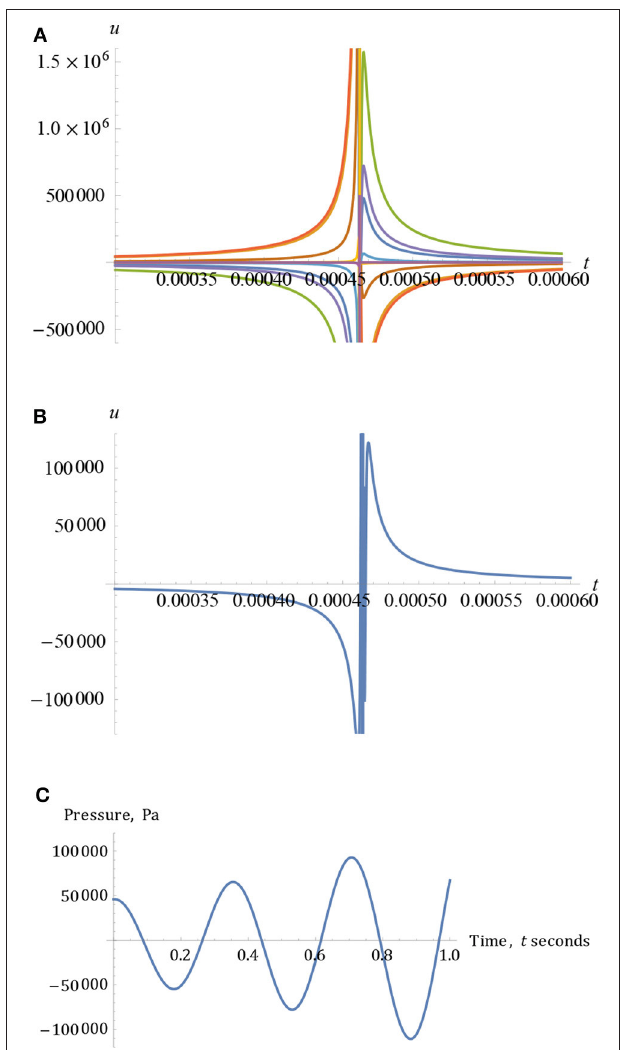
FIGURE 9 | (A) The variation of wave-pressure vs. time for a series of different transmitted and reflected waves described by Equation (76). (B) The variation of wave-pressure vs. time for the superposition of each of the waves in (A) there is a chaotic region of highly alternating pressure close to t (C) The variation of wave-pressure vs. time for